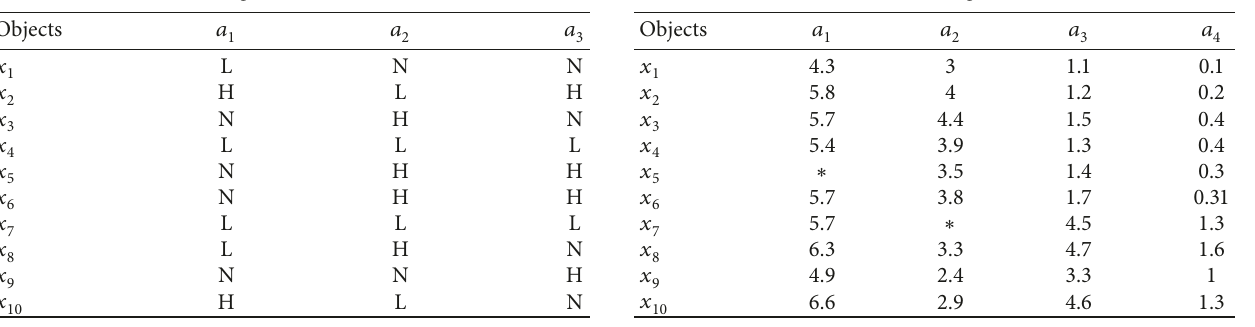
Table 6: Missing